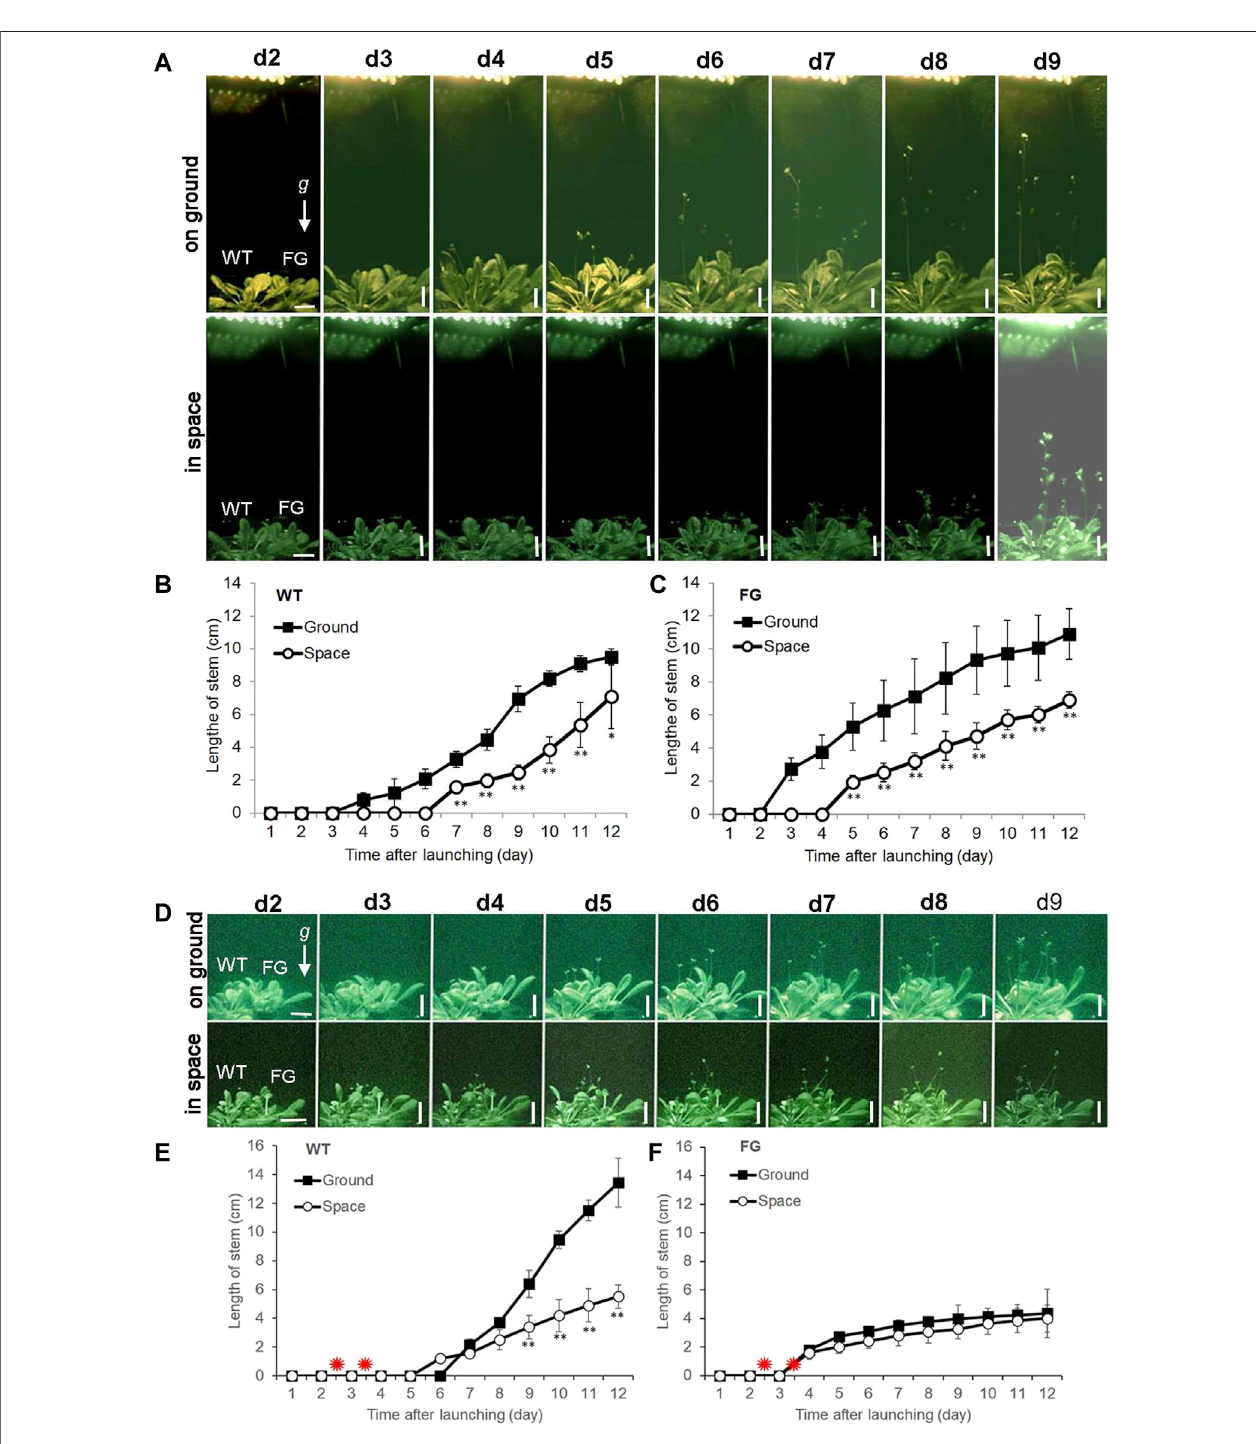
FIGURE 2 | Floral transition time of wild-type (WT) and pHSP : FT ; pHSP : GFP (FG) transgenic plants grown under the long-day (LD) and the short-day (SD) conditions on the ground and in space on board the SJ-10 satellite. (A) Exampleimages ofplants grown under theLD condition on ground and in space at day 2 (d2) to day9(d9)aftertheSJ-10tookoff.Scalebars (cid:1) 10 mm. (B,C) Comparison of fl oraltransitiontimeandaveragelengthofstemsofWTandFGtransgenicplantsunderthe LDinspacewiththeircontrolsonground.Dataaredeterminedfromthedownlinedimagesofplantsonorbitinspaceoronground.ErrorbarsindicatetheStandard deviation of the mean for the length of stems from the four plants (* p < 0.05, ** p < 0.001, Student ’ s t-test). (D) Example images of plants of WT and FG plants under the SD condition on ground and in space at d2 to d9 after the SJ-10 took off. Scale bars (cid:1) 10 mm (E,F) Comparison of fl oral transition time and average length of stems of WTandFGplantstreatedbyheatingshock(redasterisksindicate)undertheSDconditioninspaceandonground.Dataaredeterminedfromtheimagesdownlinedfrom thePGUinspaceandonground.ErrorbarsindicatetheStandarddeviationofthemeanforthelengthofstemsfromthefourplantspertreatment(** p < 0.001,Student ’ s